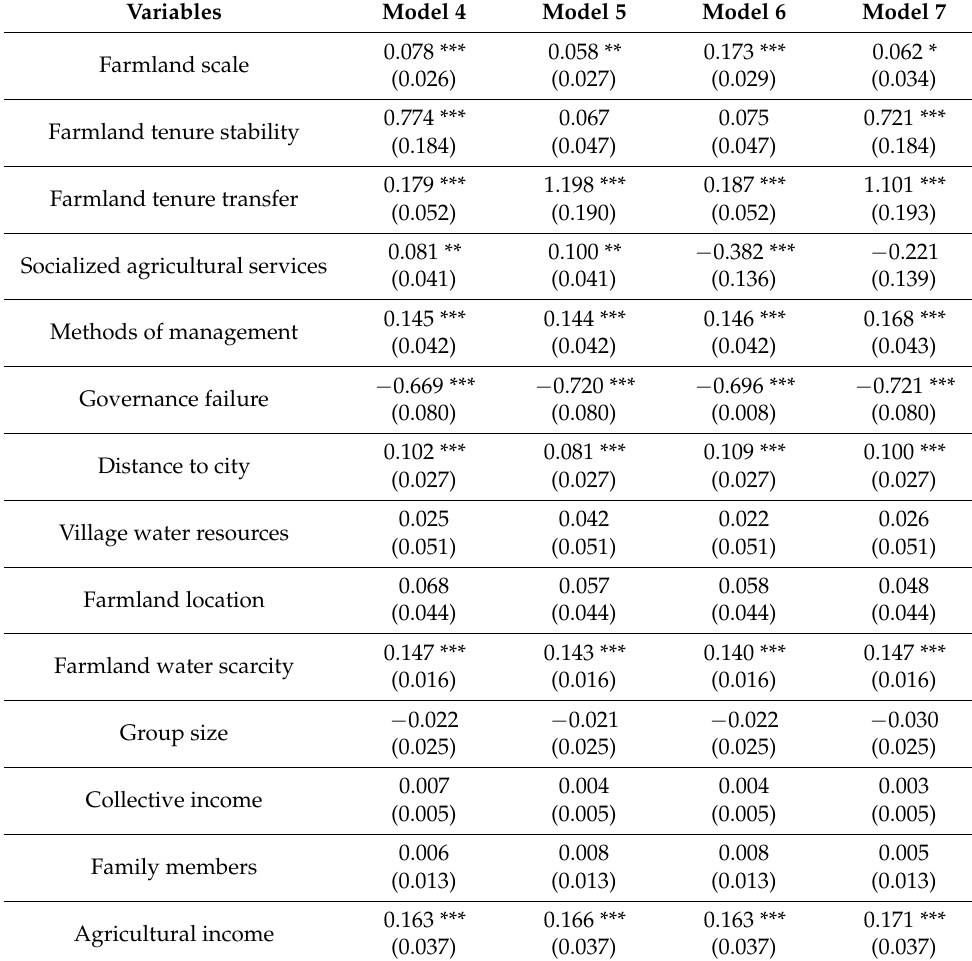
Table 4. Results of moderating